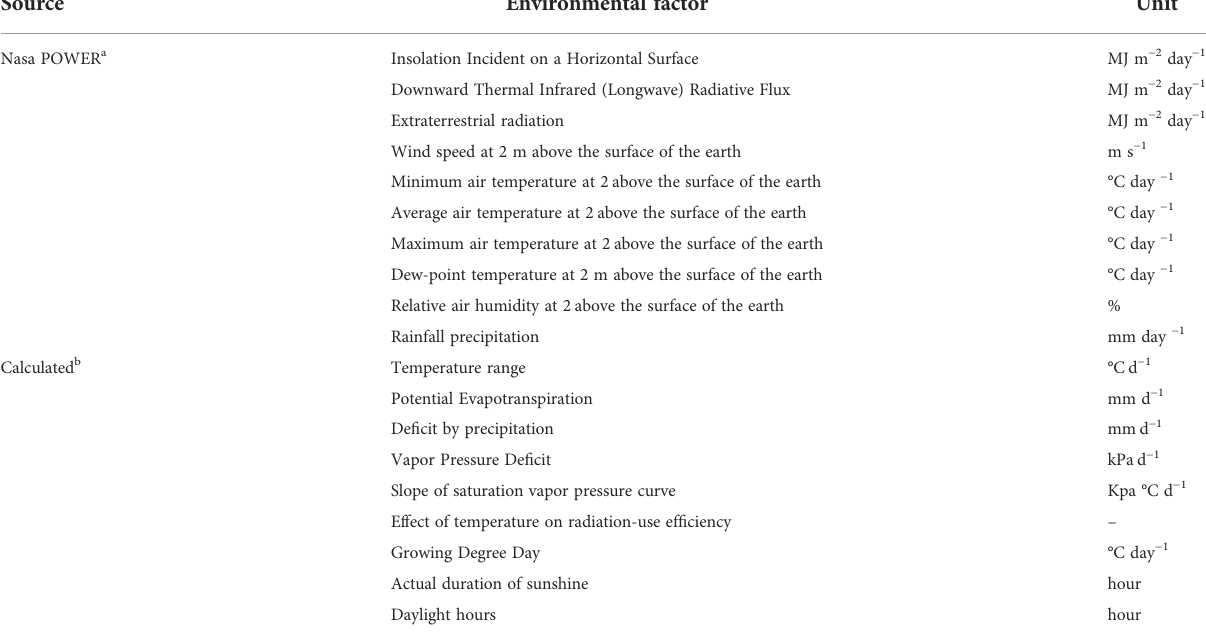
TABLE 2 List of environmental covariables used in the